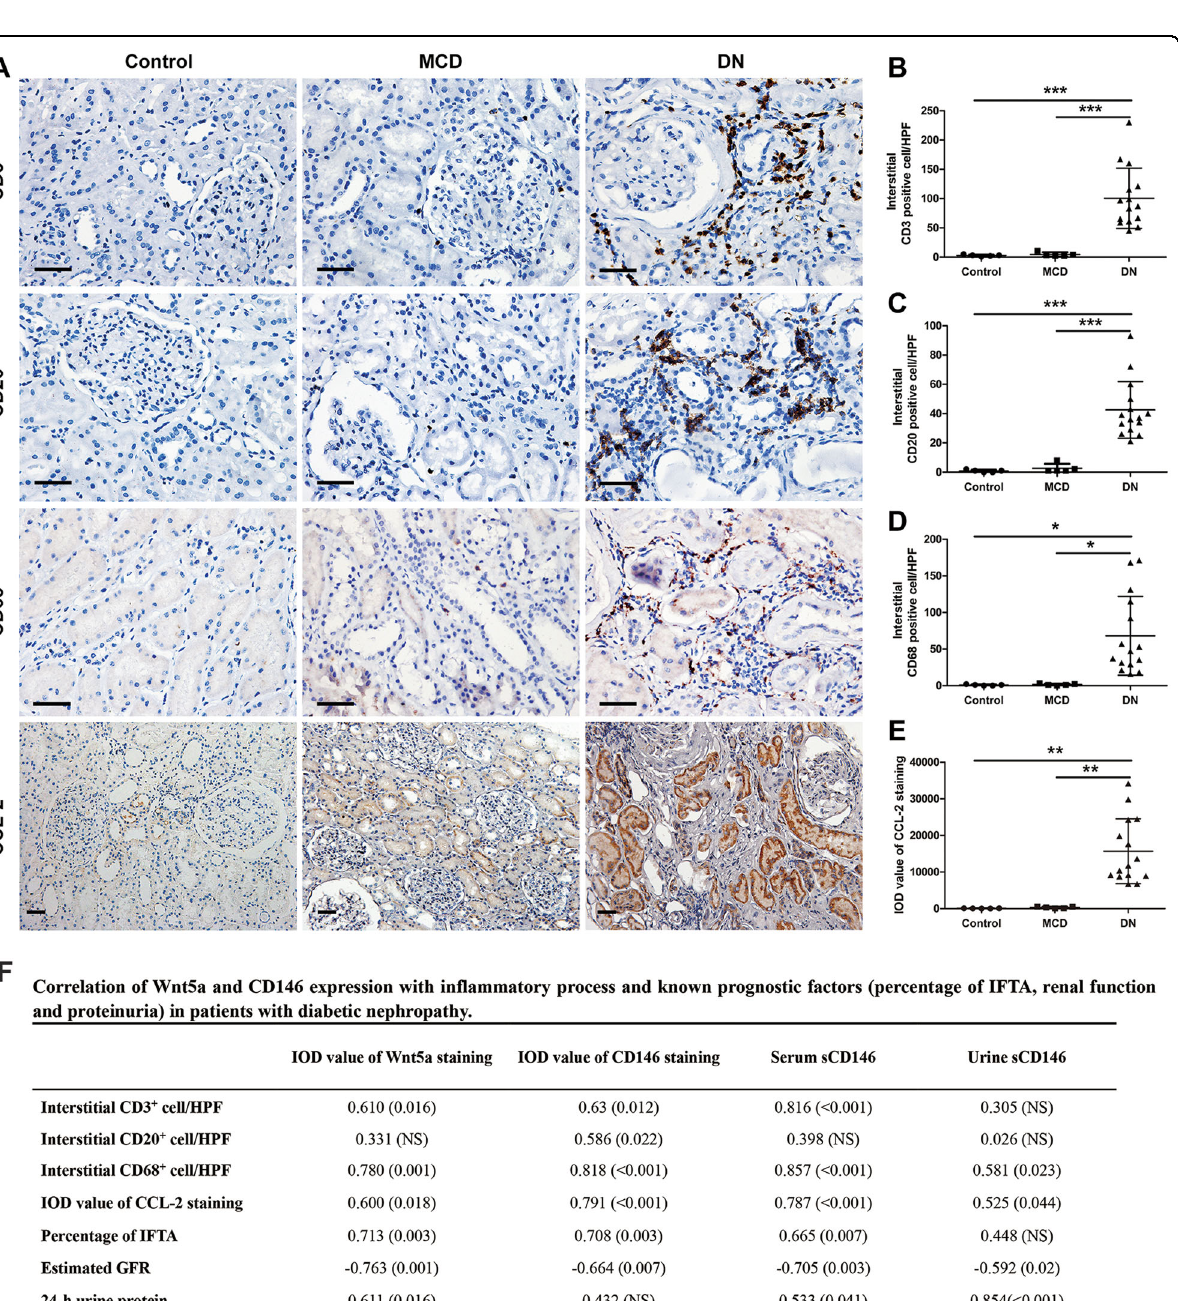
Fig. 2 Assessment of renal in fl ammation in human kidney biopsies. A Immunostaining using speci fi c antibodies for different immune cells, including T lymphocytes (CD3 + cells), B lymphocytes (CD20 + cells) and monocytes/macrophages (CD68 + cells), was performed on normal subjects, MCD patients, and DN patients. Original magni fi cation, ×400; scale bar, 50 μ m. Immunohistochemical staining of the proin fl ammatory marker, chemokine (C-C motif) ligand 2 (CCL-2) was also performed. Original magni fi cation, ×200; scale bar, 50 μ m. B – D The numbers of CD3 + , CD20 + , and CD68 + cells per high-power fi eld (HPF) were counted in the tubulointerstitium. *** P < 0.001, * P < 0.05. E Quantitative analysis of the expression of CCL-2 staining on kidney sections of each group according to the average IOD. ** P < 0.01. Immunostaining was performed in duplicate. Signi fi cant differences were determined by unpaired two-tailed t -tests. F Correlation of Wnt5a and CD146 expression with in fl ammatory process and known prognostic factors (percentage of IFTA, renal function, and proteinuria) in patients with diabetic nephropathy. Data are r value based on Pearson and Spearman correlation analysis; ( P value); NS is not signi fi cant. IFTA, interstitial fi brosis and tubular atrophy; Estimated GFR, Estimated glomerular fi ltration rate; HbA1c, hemoglobin